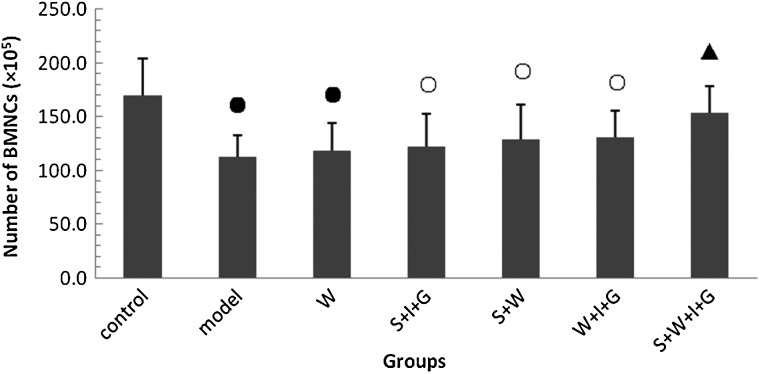
The number of bone marrow nucleated cells in experimental mice. Compared with the control group: open circle: P < 0.05; closed circle: P < 0.01. Compared with the model group: closed triangle: P < 0.01.